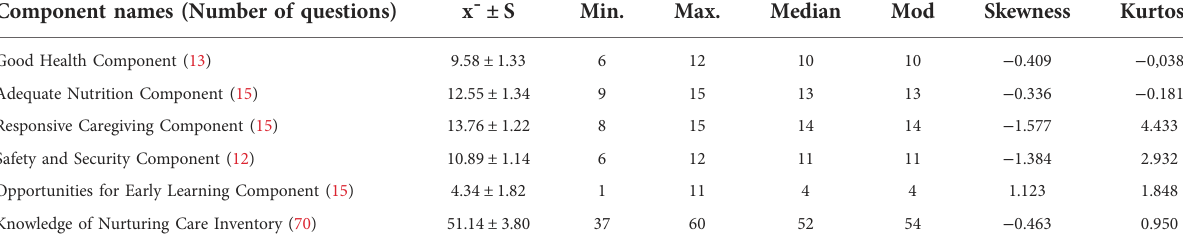
TABLE 4 Descriptive statistics on the level of knowledge on NC and its components. Component names (Number of